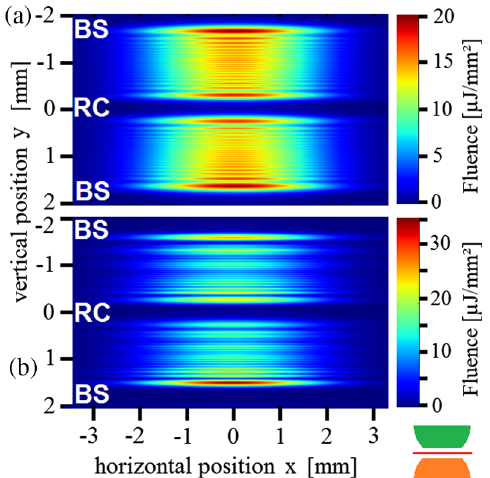
FIG. 5. The XFEL beam on the imaging detector at z ¼ 976 m split by the SDU containing ideal flat mirrors (a) and mirrors with the height profile of mirror 2 (b).